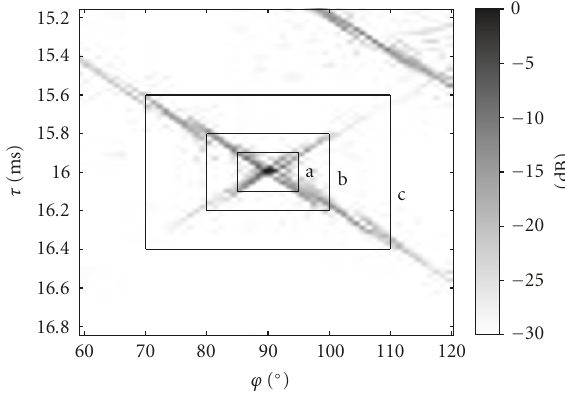
Figure 6: The model space frame for θ = 70 ◦ (see Figure 5(d)), zoomed in on the representation of the wave incident under that el- evation angle. Three filter windows shown are used for the selection of data for reconstruction in the data